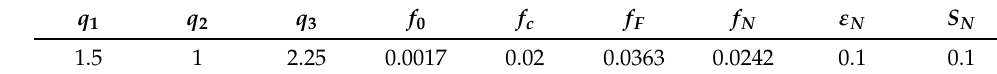
Table 2. The parameters of the GTN model used for the Al substrate [54–56].